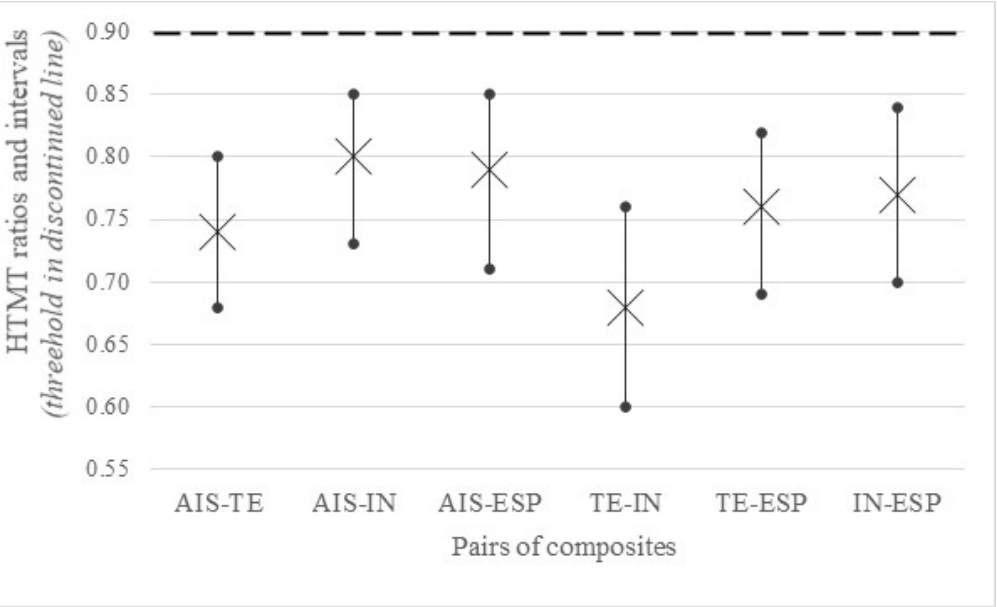
Table 4. Discriminant validity.